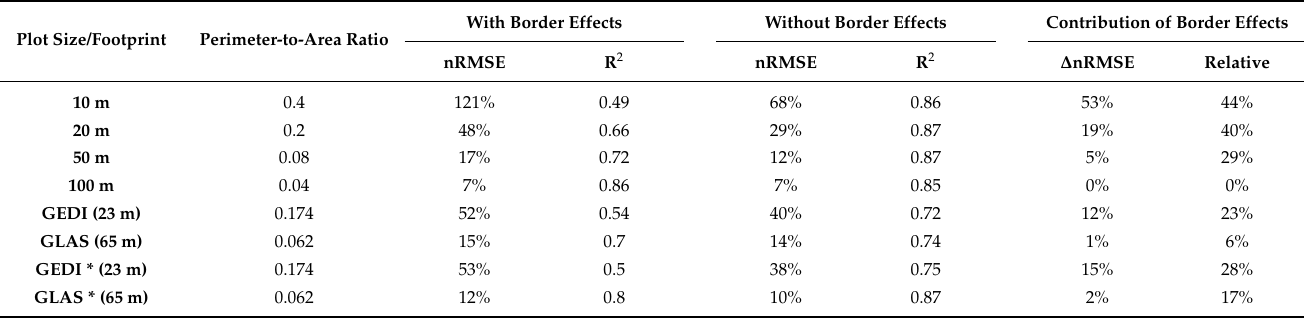
Table 3. Summary of all of the normalized root mean square errors (nRMSE) and R 2 -values for the different plot sizes and footprints with and without border effects. The difference between the nRMSE with and without borders is called ∆ nRMSE. If the ∆ nRMSE is divided by nRMSE with border effects, the relative contribution is